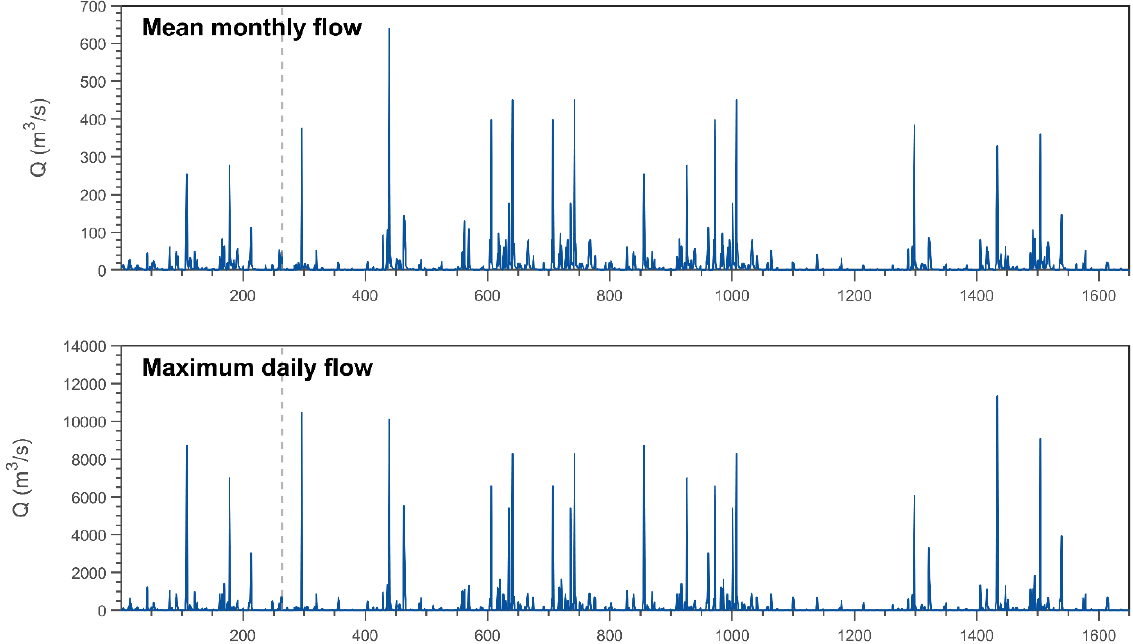
Figure A3. Mean monthly (top) and maximum daily (bottom) synthetic inflow hydrographs of additional scenario #1. The dashed line indicates the construction of the Wivenhoe Dam.